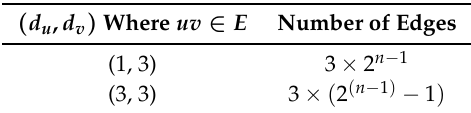
Table 1. Edge partition of Γ 2 n on the basis of degrees of end vertices of each edge.